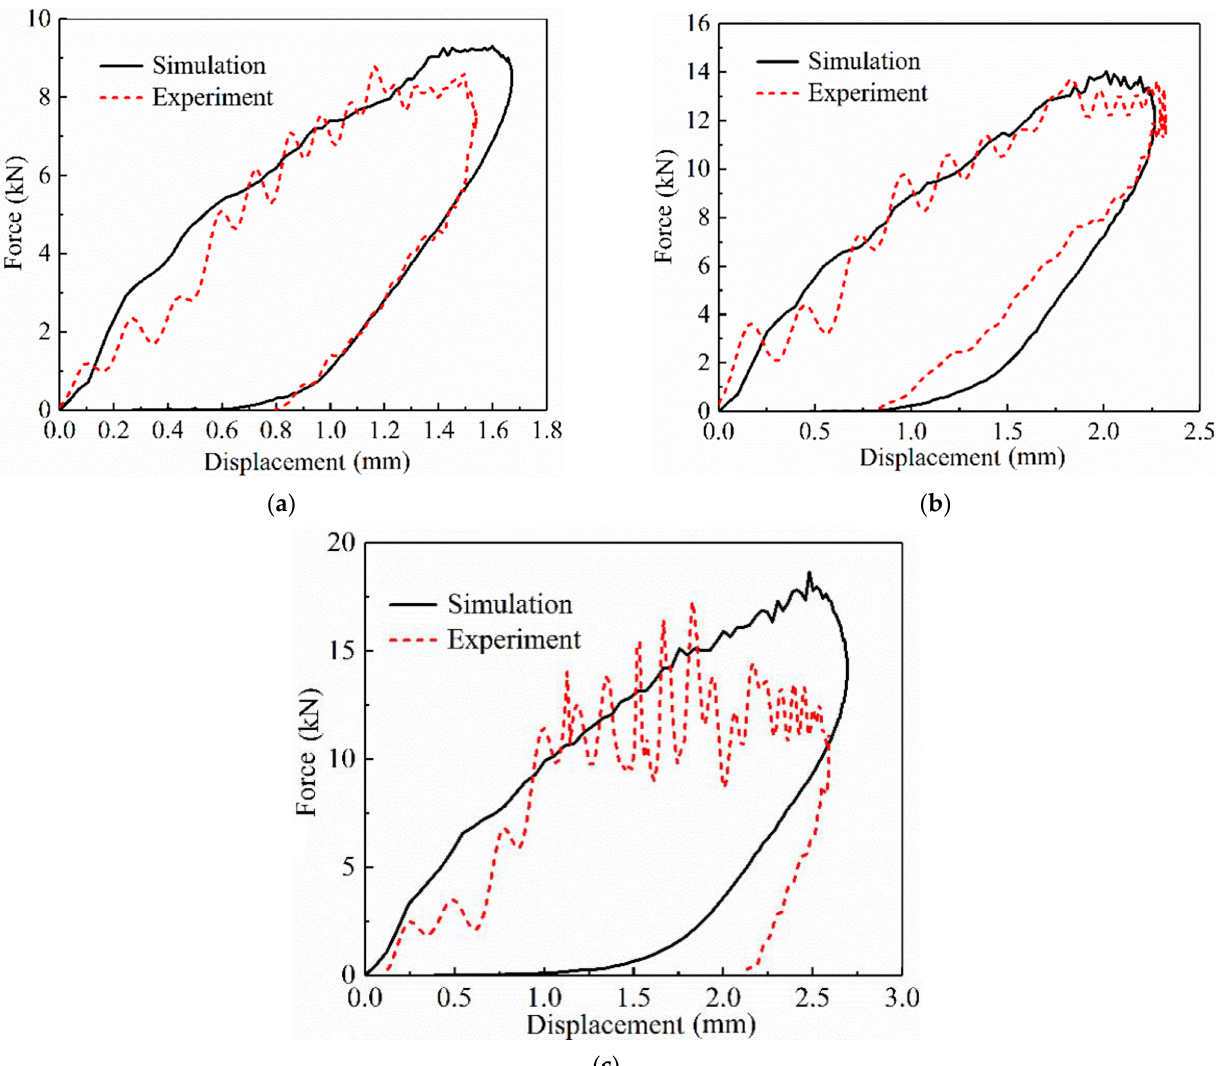
Figure 6. Curves of the impact force-displacement of the SLJs adhesively bonded structure of CFRP laminate under different impact energies. ( a ) 10 J; ( b ) 20 J; and ( c ) 30 J.